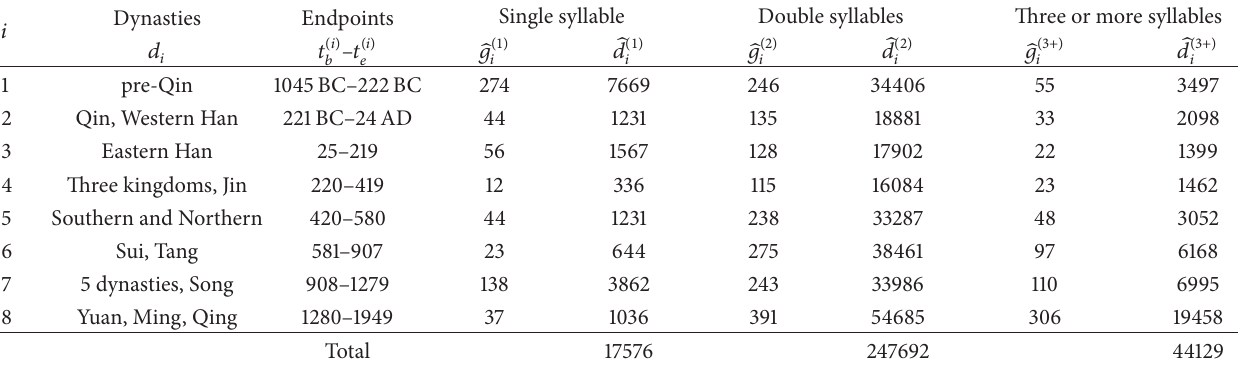
Table 1: Statistical data of words of various numbers of